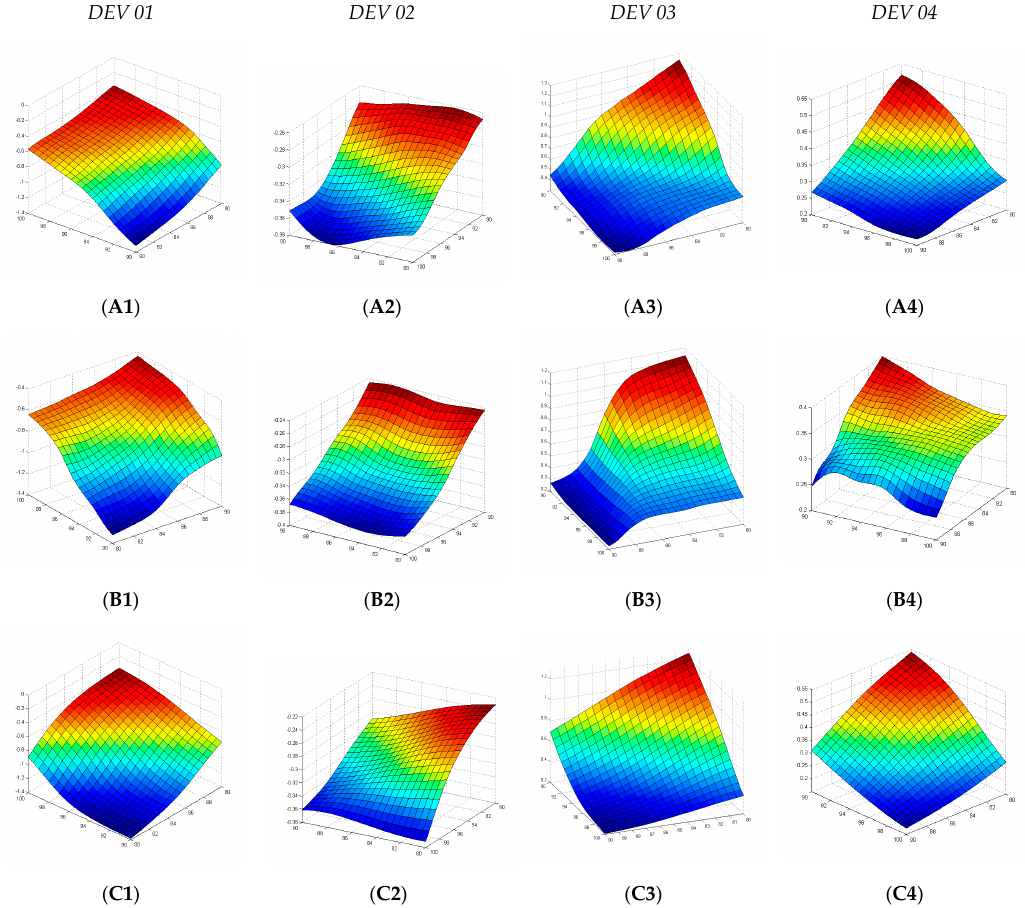
Figure 6. Comparison of the response surfaces of the models for heating time variables vs. electric heating power vs. type of deviations, being: ( A ) “Z” model, ( B ) “Y” model; and ( C ) “V” model, and DEV 01 is the dimensional deviation height, DEV 02 is the deviation of diagonal length, DEV 03 is the geometric deviation of flatness ( GD i ), and DEV 04 is geometric deviation of side angles.